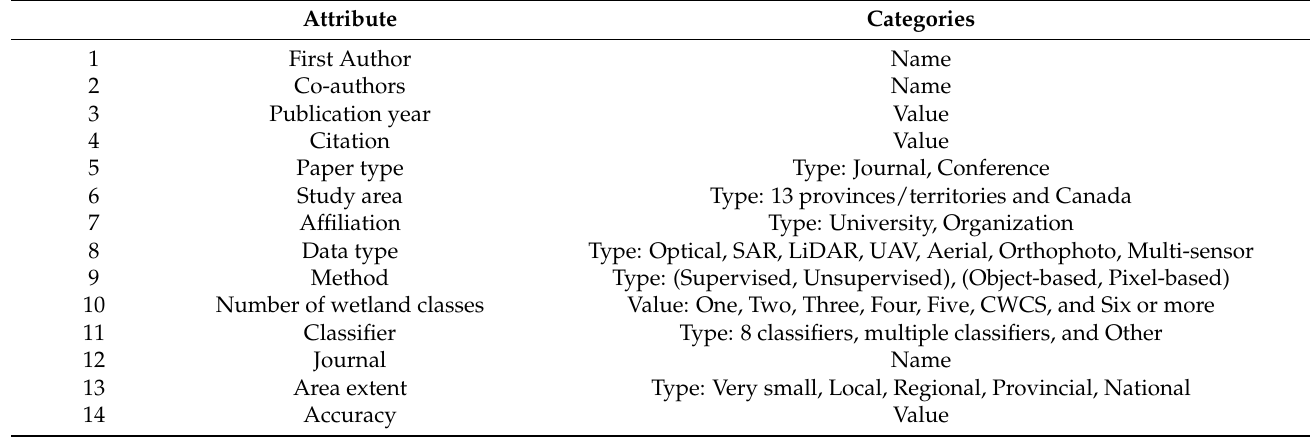
Table 2. The 14 attributes considered for content analysis of all 300 papers for further